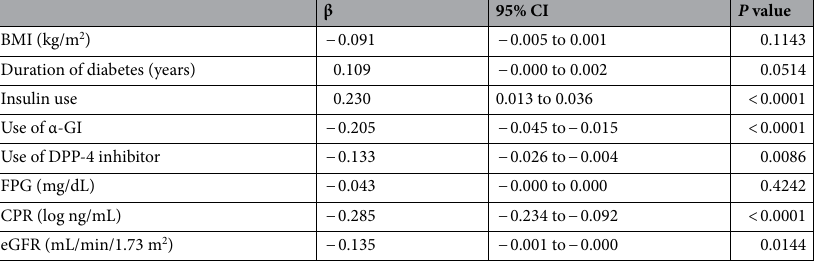
Table 4. Age, BMI, the duration of diabetes, the type of antidiabetic treatment, and FPG were associated with the CPR concentration. The indices of GV (CV, SD, and MAGE), and the key CGM indices (LBGI, HBGI, TBR, TIR, and TAR), were also associated with the CPR concentration. The mean glucose profiles of the patients in each of the three CPR groups are shown in Fig. 2. In summary, the GV appeared to be more unstable in the low CPR group than in the moderate and high CPR groups. Supplementary Figure S3 shows the CV distribution among the three subgroups. The number of patients with CV ≥ 36%, defined as unstable GV, was significantly higher in the low CPR subgroup than in the medium and high CPR subgroups (Table 4).